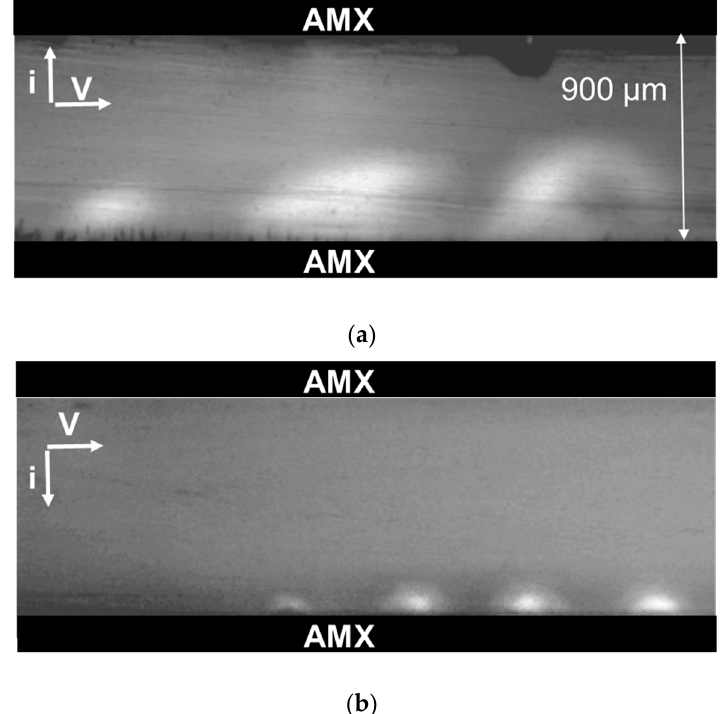
Figure 6. Visualization of the vortex structures at the AMX membrane surface in the desalination channel of the electrodialysis cell, where a 0.01 M NaCl solution ( a ) or a 0.01 M NaH 2 PO 4 ( b ) was pumped. The intermembrane distance was h = 0.9 mm, the channel length was L = 3 mm, the linear flow velocity of the solution was V = 1 mm/s; i/i limLev = 6.